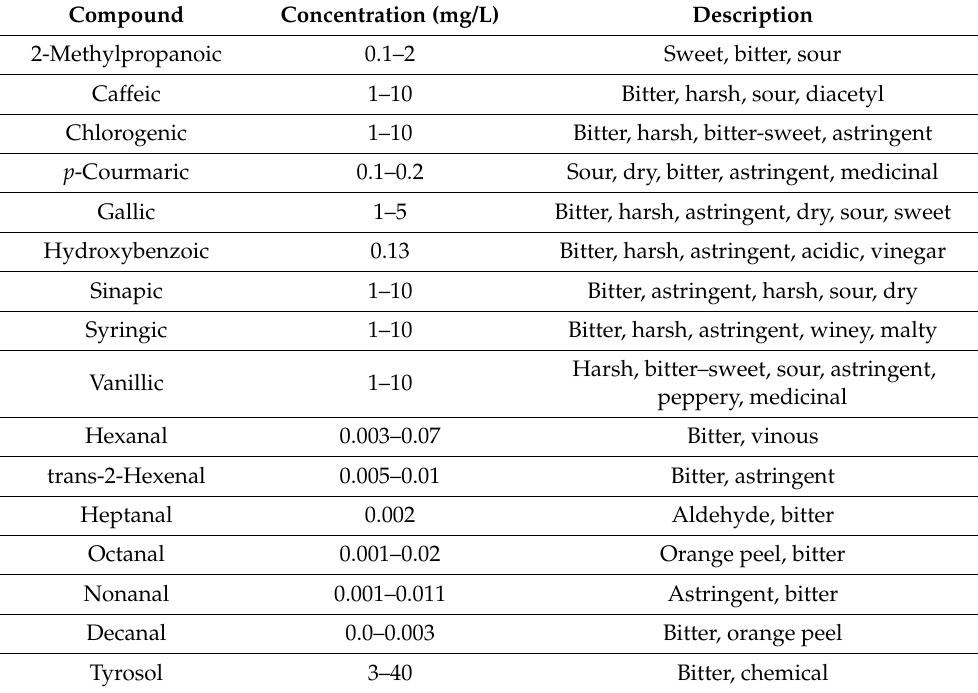
Table 1. Astringent/bitter compounds commonly found in beer adjusted from